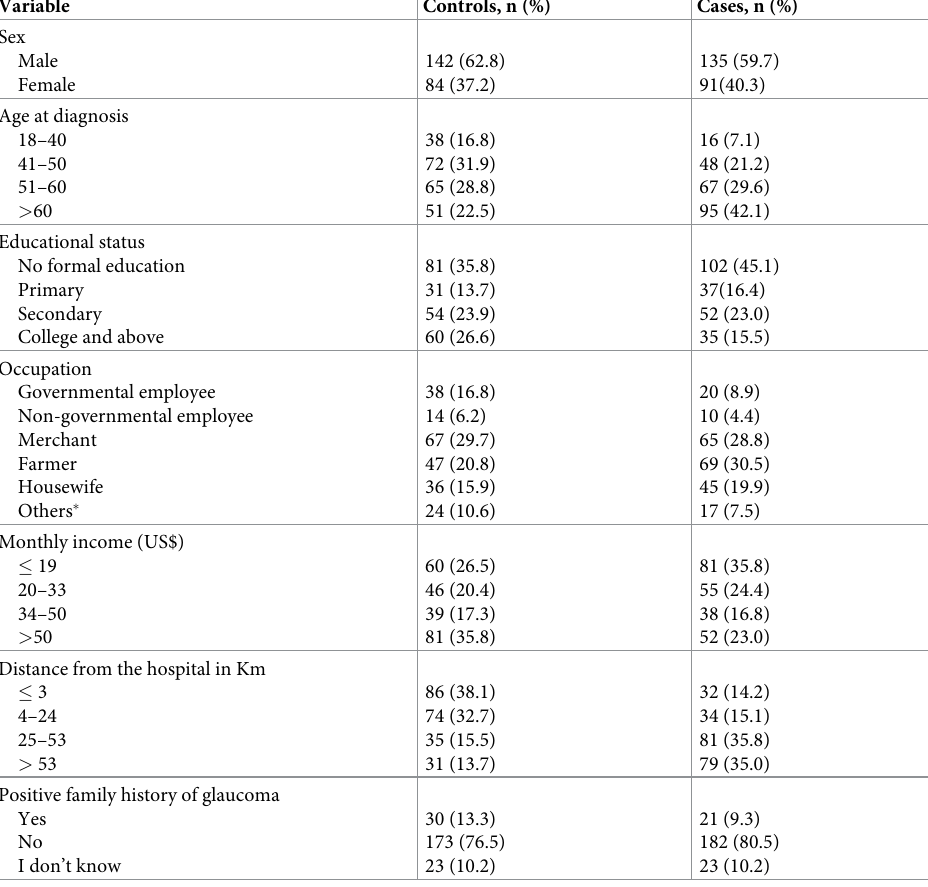
Table 1. Socio-demographic characteristics of study participants in University of Gondar Comprehensive Special- ized Hospital, Northwest Ethiopia, 2020. Variable Controls, n (%) Cases, n